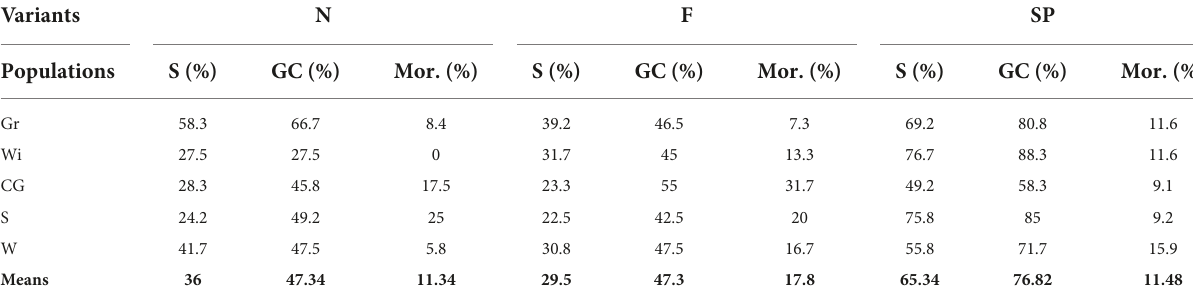
TABLE 4 Detailed variation of traits (GC, S, and Mor.) in the analyzed variants (N, F, SP) of the experiment.